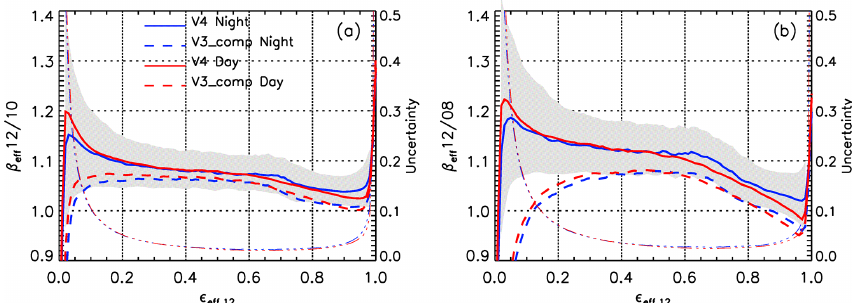
Figure 5. (a) β eff 12 / 10 and (b) β eff 12 / 08 microphysical indices vs. effective emissivity at 12.05µm in single-layered ice clouds over oceans between 60 ◦ S and 60 ◦ N in January 2008 in V4 (solid lines) and in V3_comp (dashed lines). The blue and red curves are the median values for nighttime (blue) and daytime (red), and the shaded gray areas are between the V4 nighttime 25th and 75th percentiles. The blue (night) and red (day) thin dashed–dotted lines are the V4 random absolute uncertainty estimates with the vertical axis on the right-hand side of each panel.